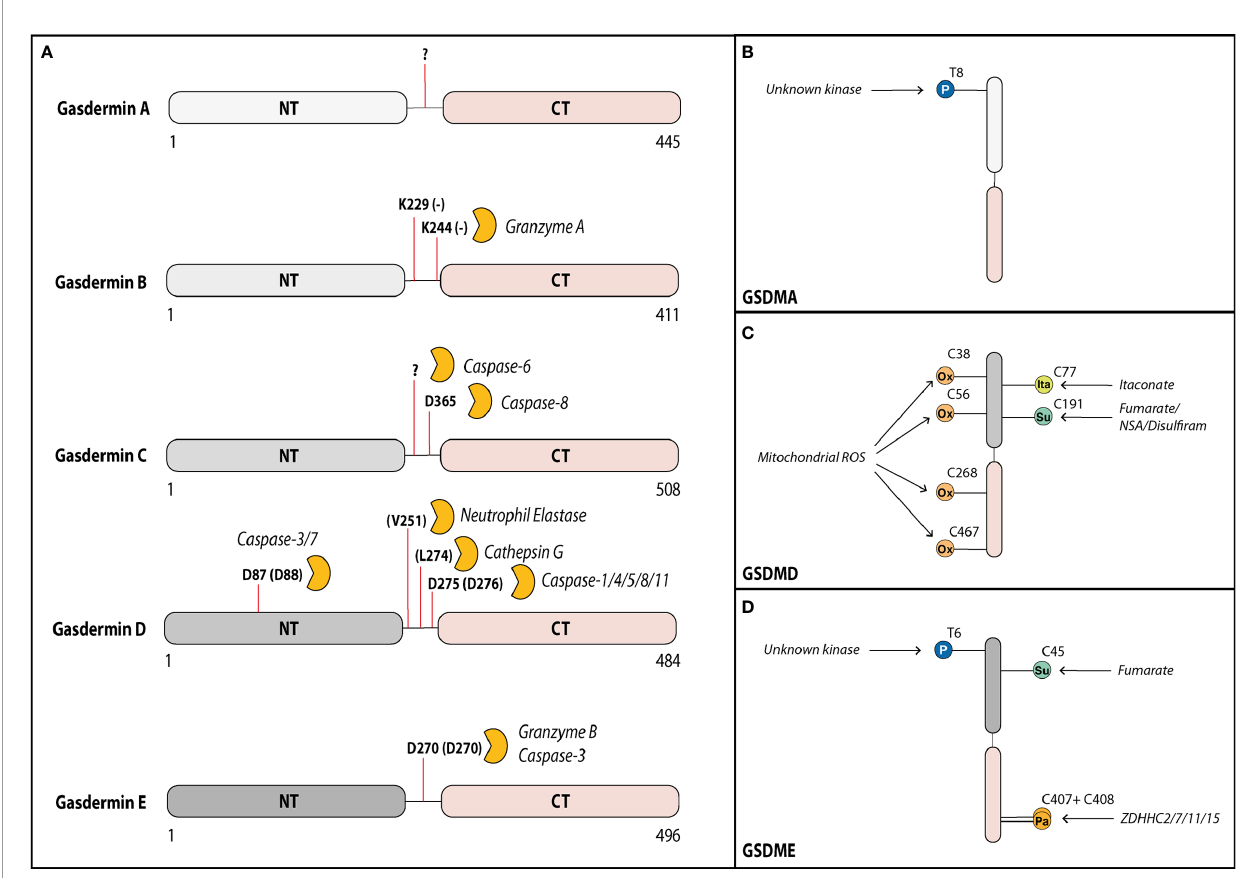
FIGURE 1 | Gasdermins can be cleaved by various proteases in their linker region. Activity of gasdermins is regulated by cleavage and by post-translational modi fi cations. (A) Gasdermin A can form membrane pores after cleavage of the linker domain, but the cleaving protease remains unknown. In tumor cells, Gasdermin B can be cleaved by granzyme A from cytotoxic T cells at Lys229 and Lys244 into the pore forming fragment. In several cell types including most myeloid cells, gasdermin D can be cleaved by multiple proteases at Asp275 (mouse Asp276) leading to its activation, but it can additionally be cleaved at Asp87 (mouse Asp88) by caspase-3 and -7 inactivating it during apoptosis. In neutrophils, gasdermin D can also be cleaved by neutrophil elastase and cathepsin D. In response to some chemotherapy drugs, gasdermin C can be cleaved by caspase-6 (at unknown site) and caspase-8 (at Asp365) into the pore forming fragment. Gasdermin E can be cleaved by granzyme B or caspase-3 at Asp270 leading to activation. Activity of gasdermins is also regulated by several post-translational modi fi cations. (B) Gasdermin A can be phosphorylated (P) by an unknown kinase at Thr8, supporting its pore-forming capacity. (C) Gasdermin D is oxidized (Ox) at multiple residues (Cys38, Cys56, Cys268 and Cys467) by reactive oxygen species from the mitochondria promoting its activation. Prolonged LPS exposure of macrophages results in binding of itaconate at Cys77 preventing gasdermin D cleavage. Gasdermin D can also be succinated (Su) at Cys191 by the metabolic product fumarate or by covalent binding of the cysteine-reactive drugs necrosulfonamide (NSA) or disul fi ram, which prevents its oligomerization. (D) Similar to gasdermin A, gasdermin E is phosphorylated at Thr6 promoting its pore formation. Gasdermin E is inhibited by succination at Cys45. During the activation, the palmitoyltransferases ZDHHC2, -7, -11 and -15 palmitoylate (Pa) gasdermin E at Cys407 and Cys408 promoting the dissociation of the GSDME-NT from